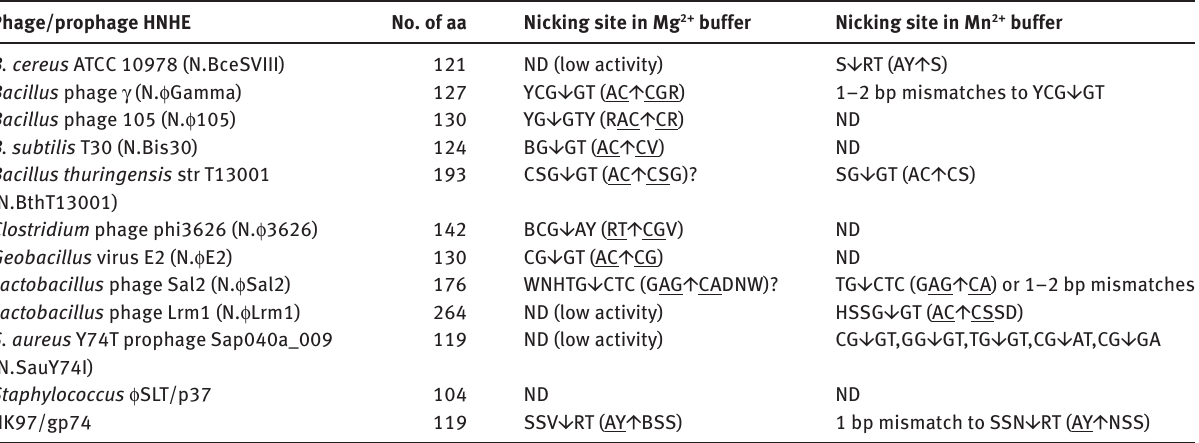
Table 1: Summary of DNA nicking sites by phage- or prophage-encoded HNH NEases. Phage/prophage